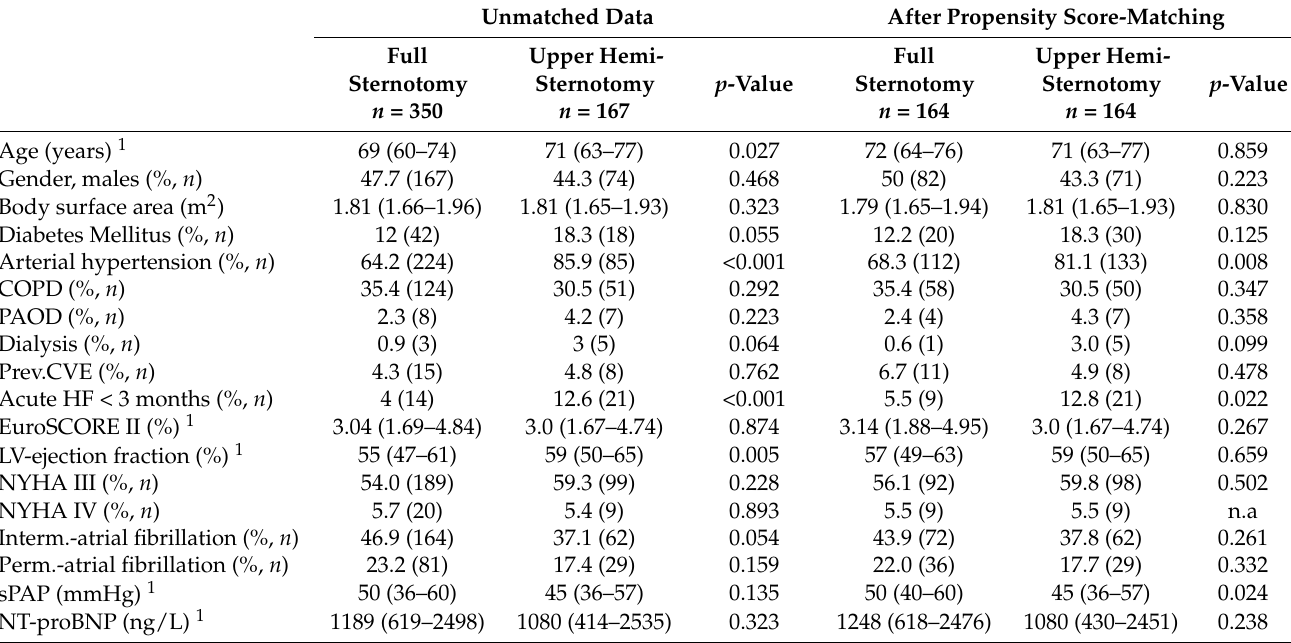
Table 1. Baseline characteristics of the study cohorts before and after propensity score